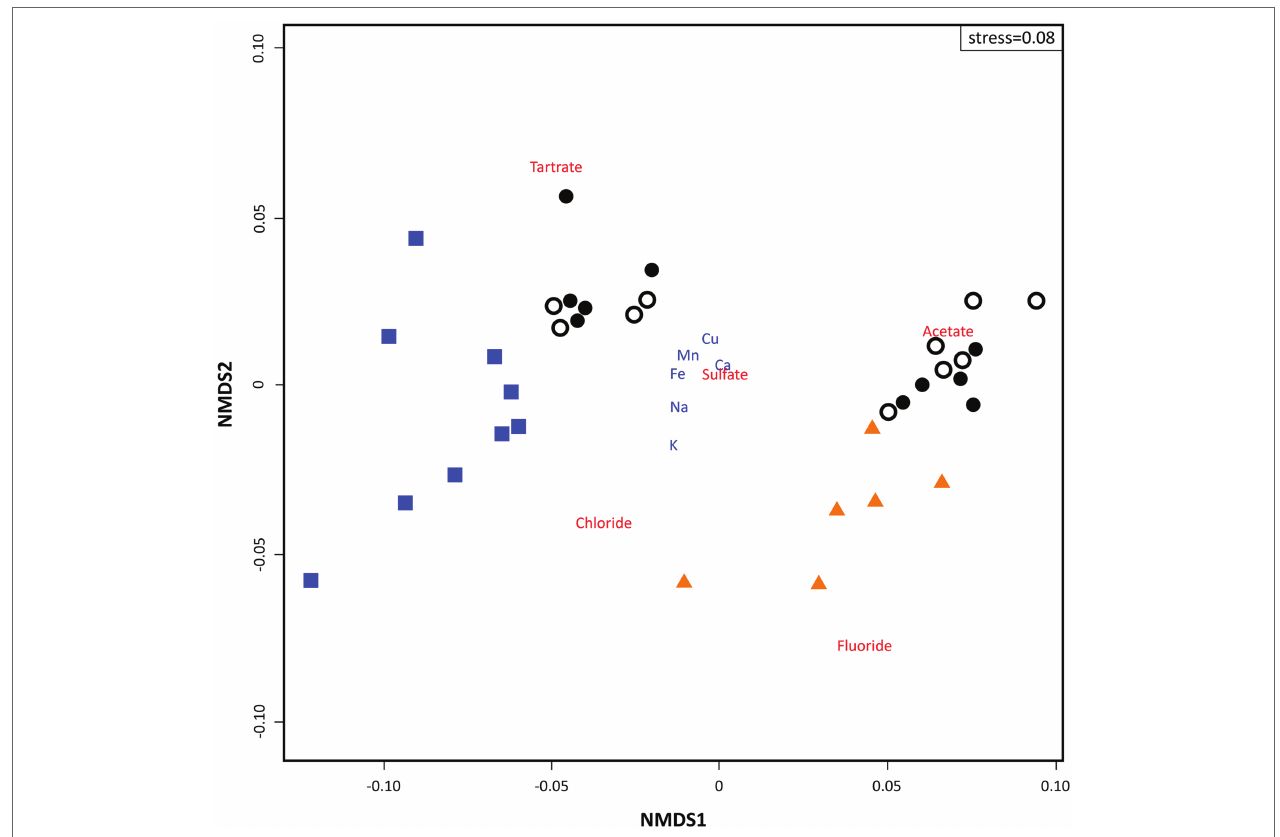
FIGURE 3 | Two dimensional non-metric multidimensional scaling (NMDS) ordination plot of sampling points (based on Bray-Curtis similarities) based on geochemical data analysis (stress = 0.08). Triangles depict ‘Bedrock’ samples; white dots depict ‘Surface soil’ samples; black dots depict ‘10 cm-depth’ samples; and squares depict ‘Loose rock’ samples. ICP-MS data appear in blue font and IC in